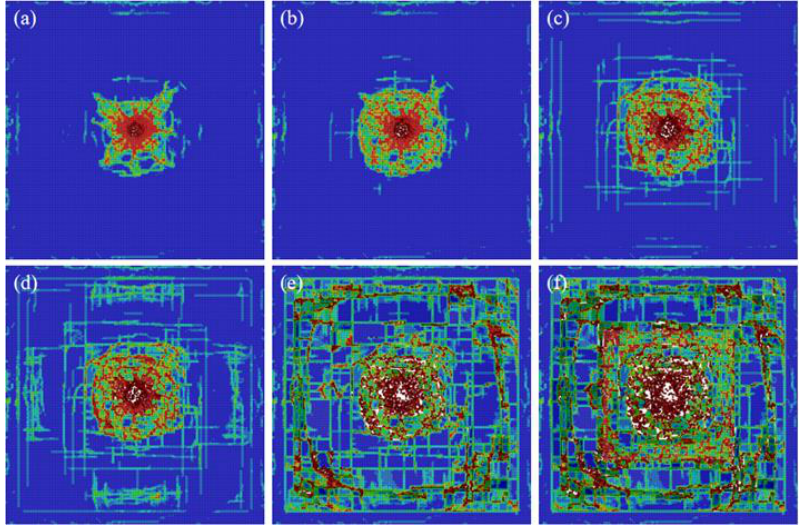
Figure 8. The time evolution of the damage map for the inorganic glass layer. From ( a – f ): snapshots taken at 40, 60, 80, 220, 840, and 2000 μs from the contact between the bullet and the transparent sandwich structure.